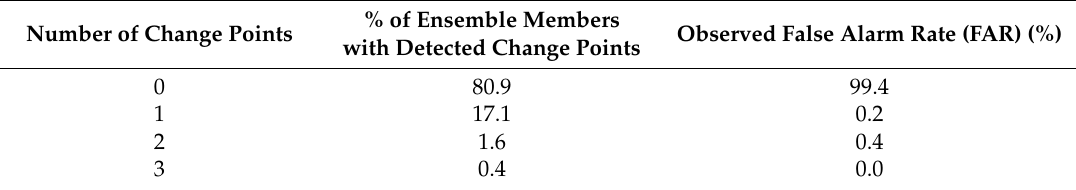
Table 4. Number of change points detected vs. percentage (%) of the 1000 ensemble members for the GTMBA analysis. Also listed is the number of change points detected when the observations are replaced with